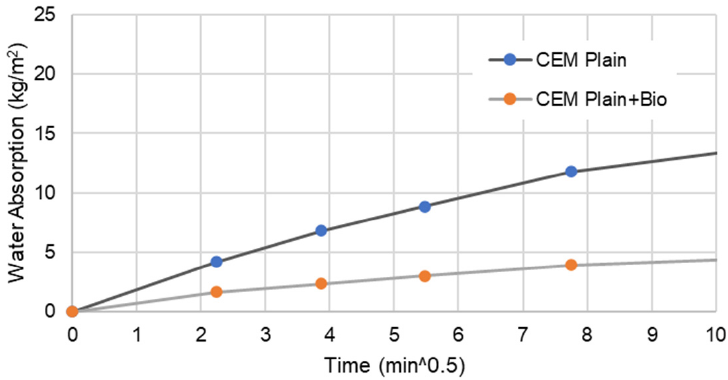
Figure 8. Water absorption for bio and non-bio cement mortar samples during the first 1